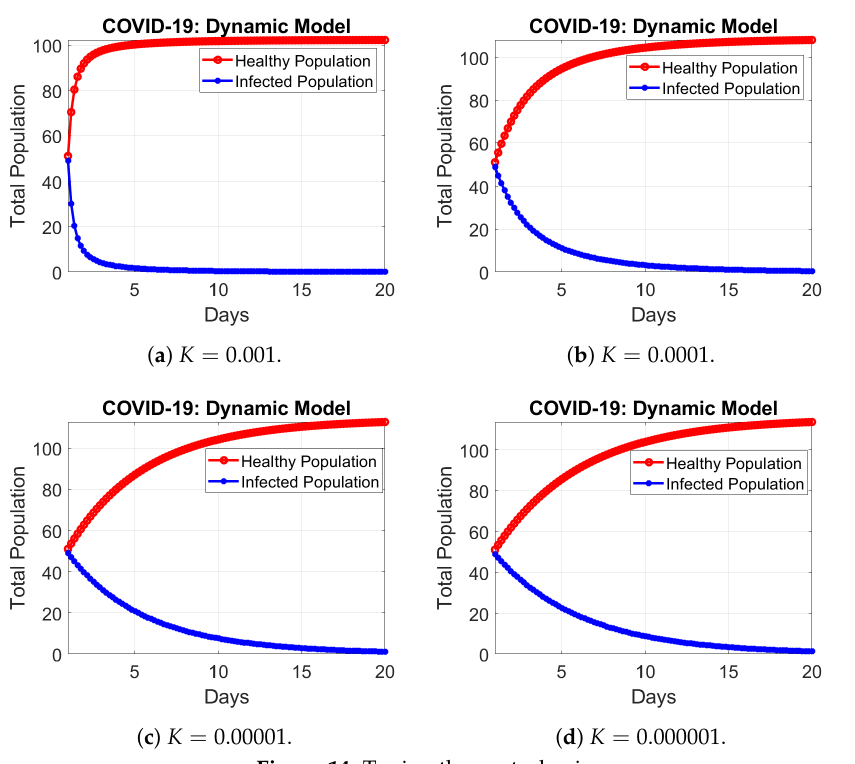
Figure 14. Tuning the control